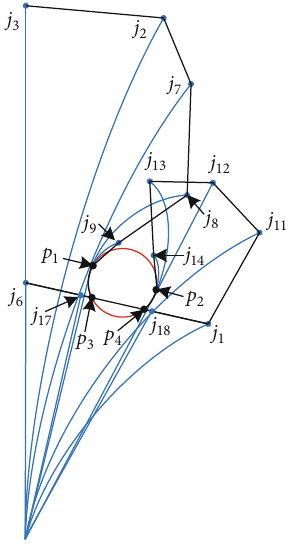
Figure 13: Landing footprints for Case